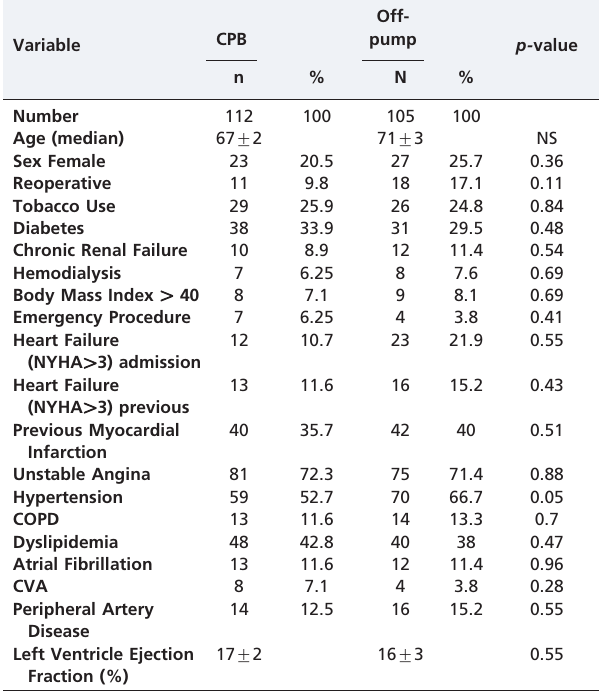
NYHA: New York Heart Association. COPD: Chronic Obstructive Pulmonary Disease. CVA: Cerebrovascular Accident. NS: